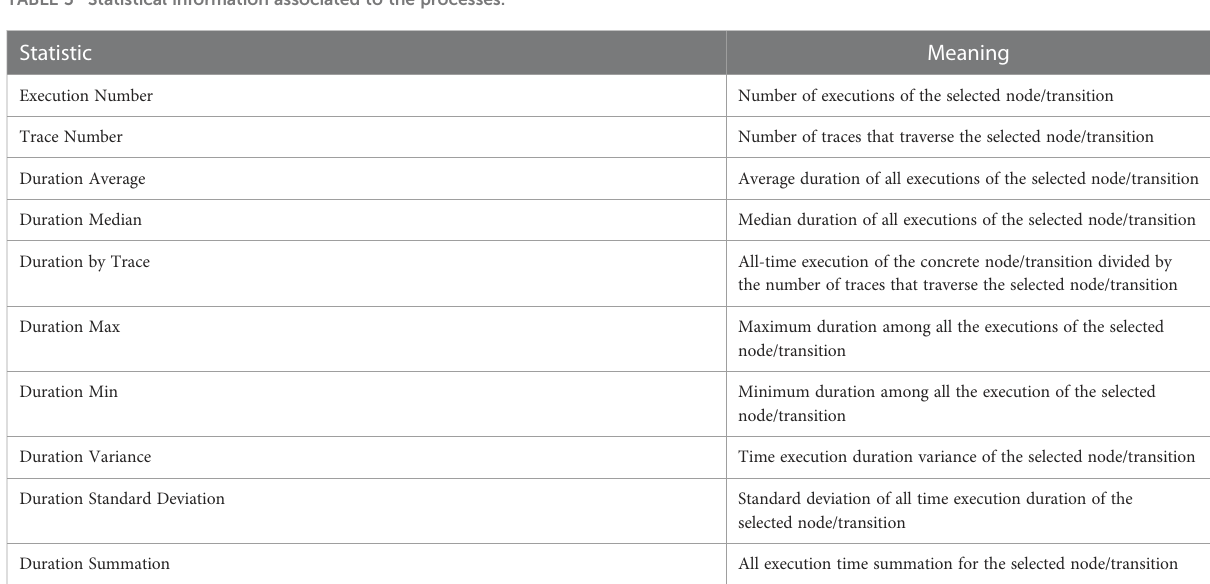
TABLE 5 Statistical information associated to the